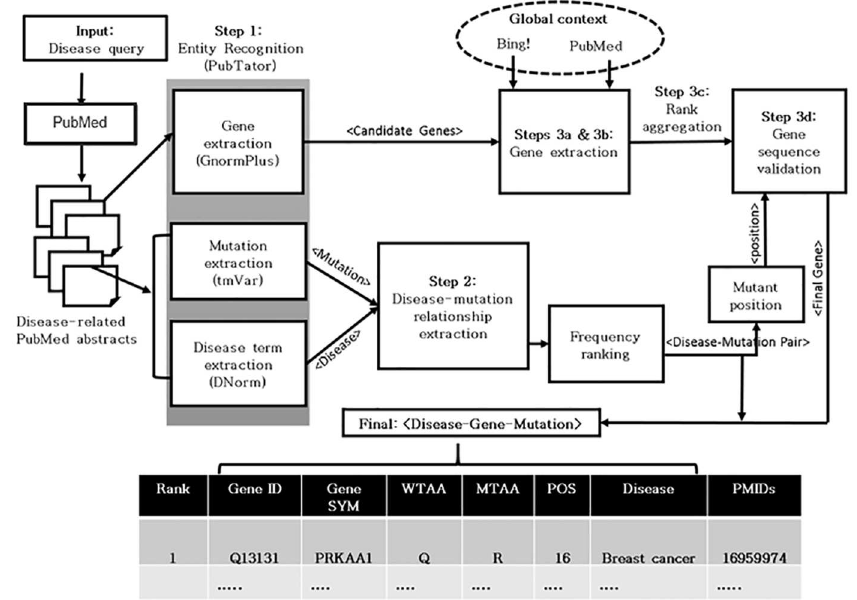
Fig 2. Overviewof the proposed